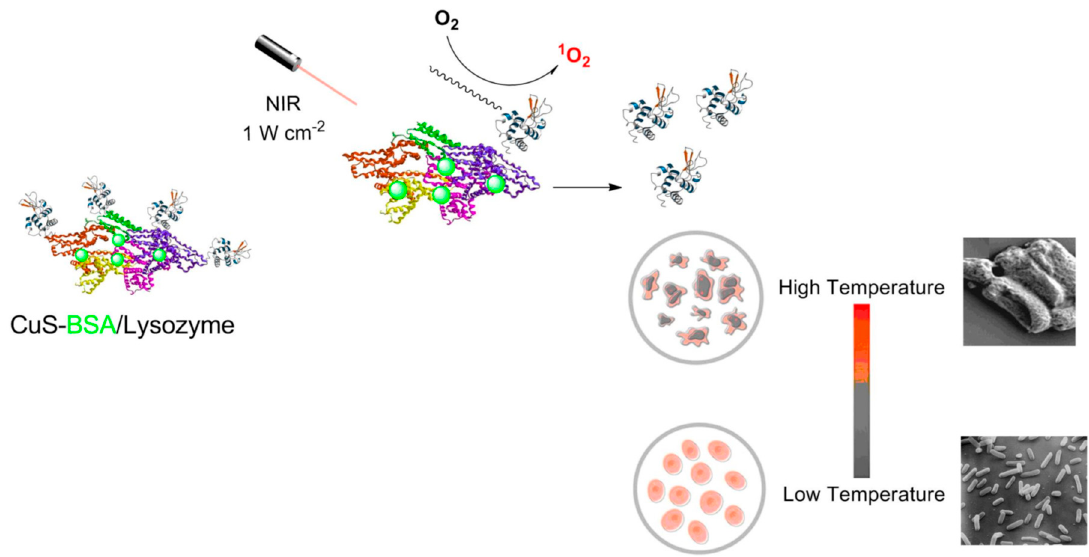
Figure 5. Schematic illustration of PDT and PTT mediated antibacterial activity of BSA-CuS nanocomposite. Reproduced with permission from Ref. [77]. Copyright 2021 MDPI AG.